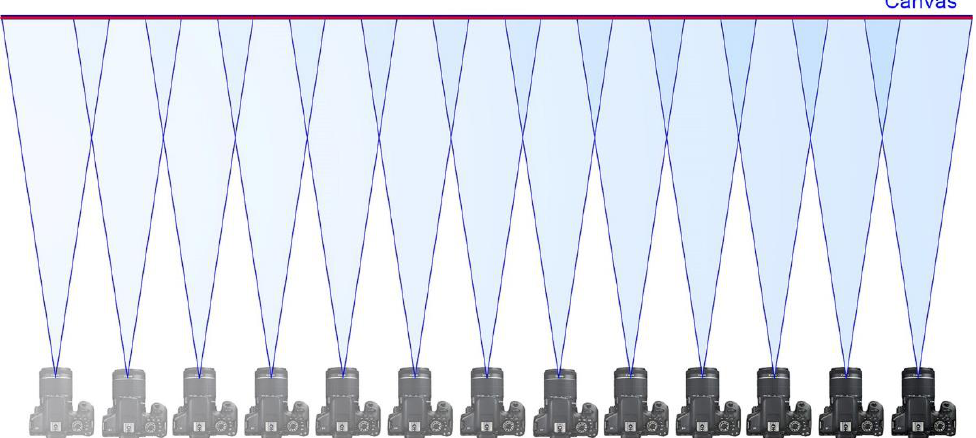
Figure 5. Parallel camera translation to take all the pictures frontally to the canvas.